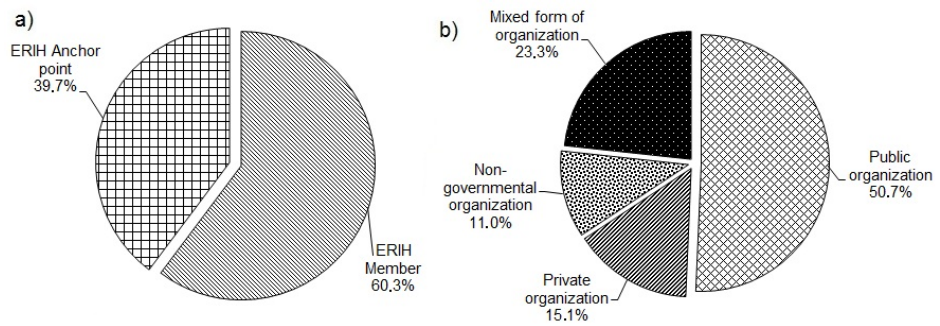
Figure 2. Type of membership of the examined sites ( a ) and their form of ownership ( b ). Table 2. Themed issues presented by the examined tourist